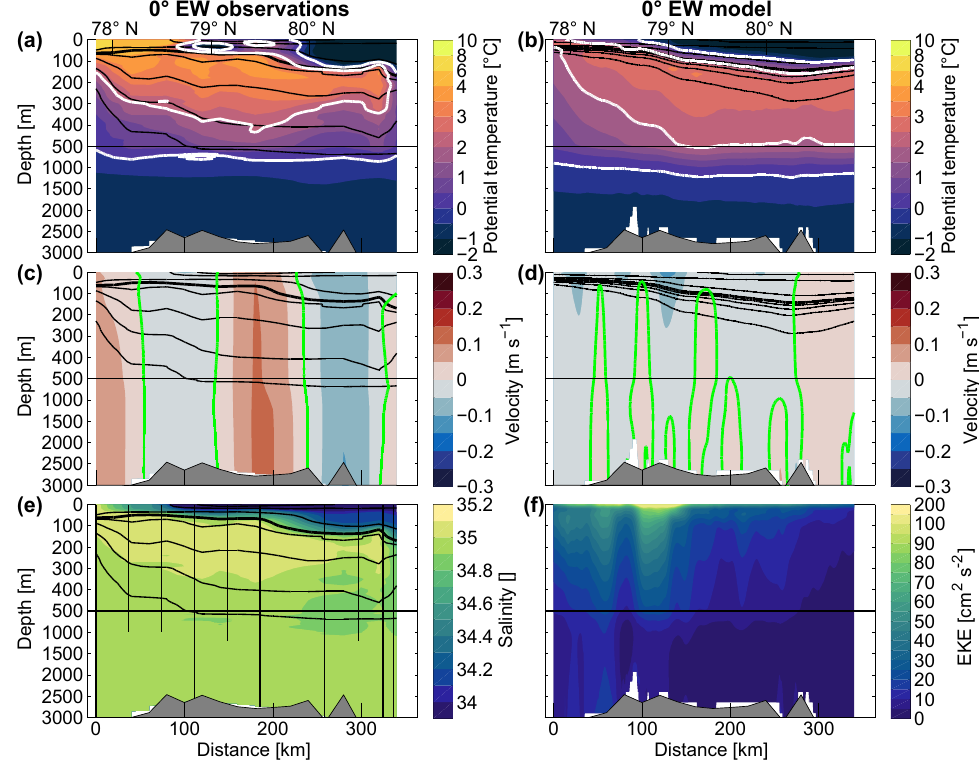
Figure 5. Left column: (a) Potential temperature, (c) absolute geostrophic velocity and (e) salinity as in Fig. 3 but for the section at 0 ◦ EW. The southernmost station was sampled last, 24 days after its northern neighbour. The next two stations were sampled 13 days after their northern neighbour. All remaining stations were occupied within 4 days. Right column: eight year July/August/September average FESOM realizations of (b) potential temperature, (d) velocity and (f) EKE as in Fig. 4 but for the section at 0 ◦ EW. Positive velocities are eastward, negative velocities are